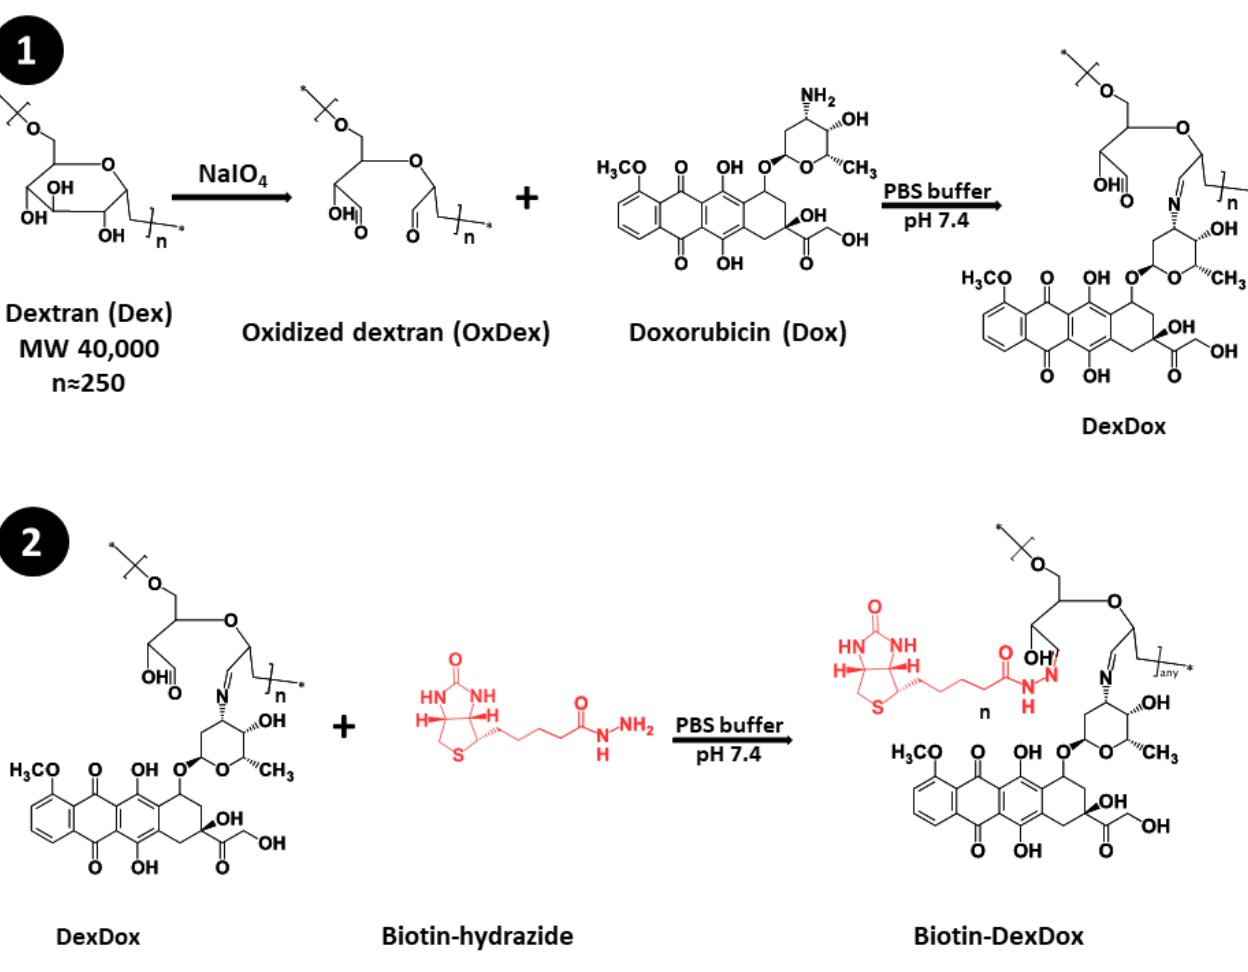
Figure 1. Preparation of Biotin-DexDox, including ( 1 ) the functionalization of the dextran with doxorubicin through its oxidation to oxidized, followed by amidation reaction with doxorubicin, and ( 2 ) biotinylation using biotin-hydrazide.